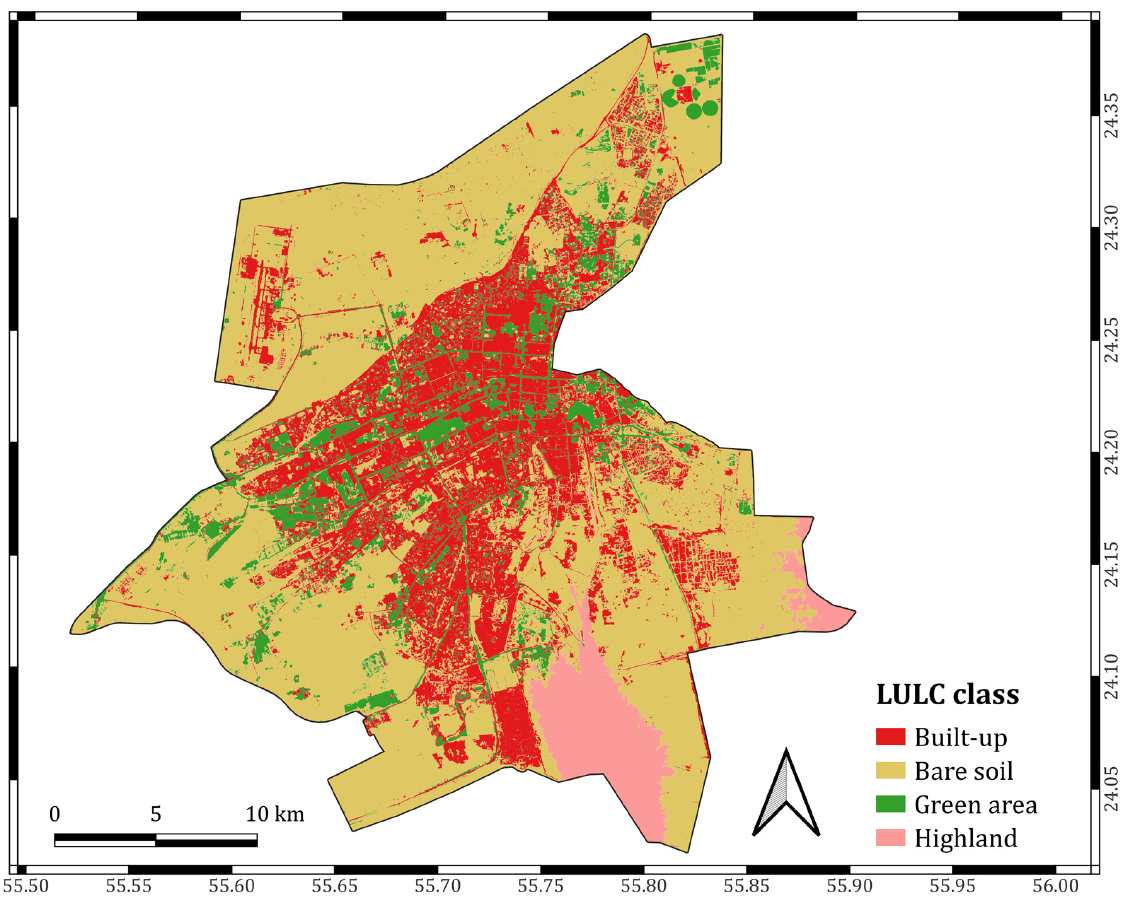
Figure 3. Land use land cover of map of Al Ain city.